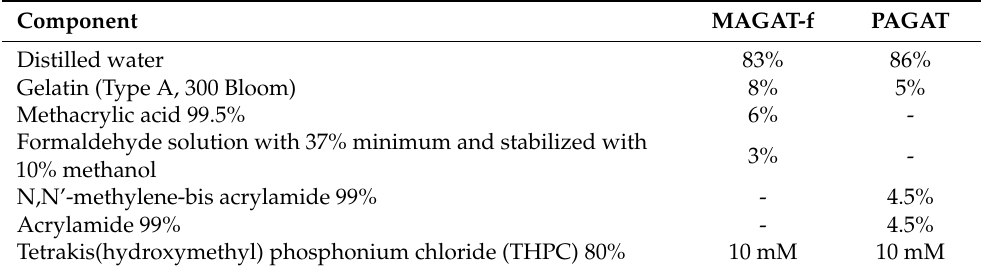
Table 1. Mass concentration of each polymer gel